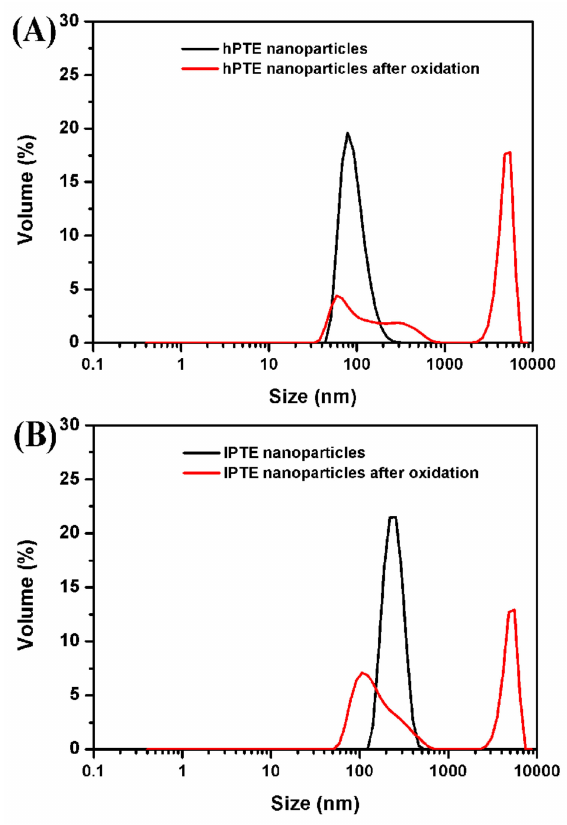
Figure 8. DLS plots of hPTE-1 ( A ) and lPTE-1 ( B ) nanoparticles treated with 3% ( w / v ) H 2 O 2 at 25 ◦ C for 4